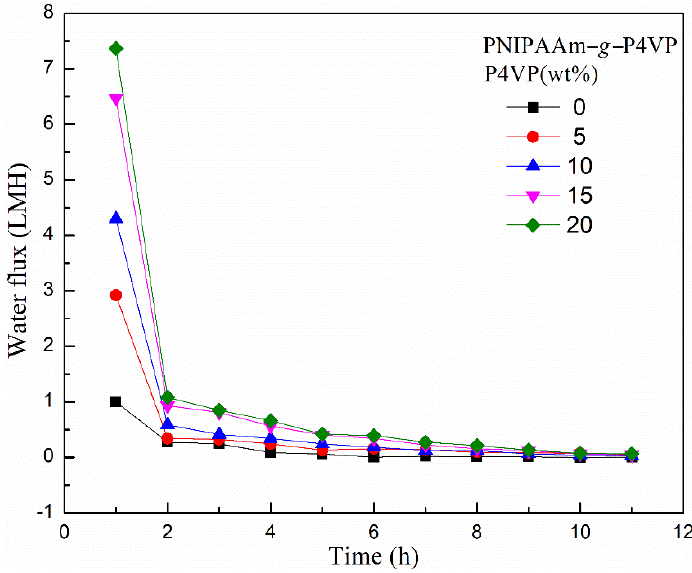
Figure 4. Water flux measurement graph of PNIPAAm microgel modified with P4VP.